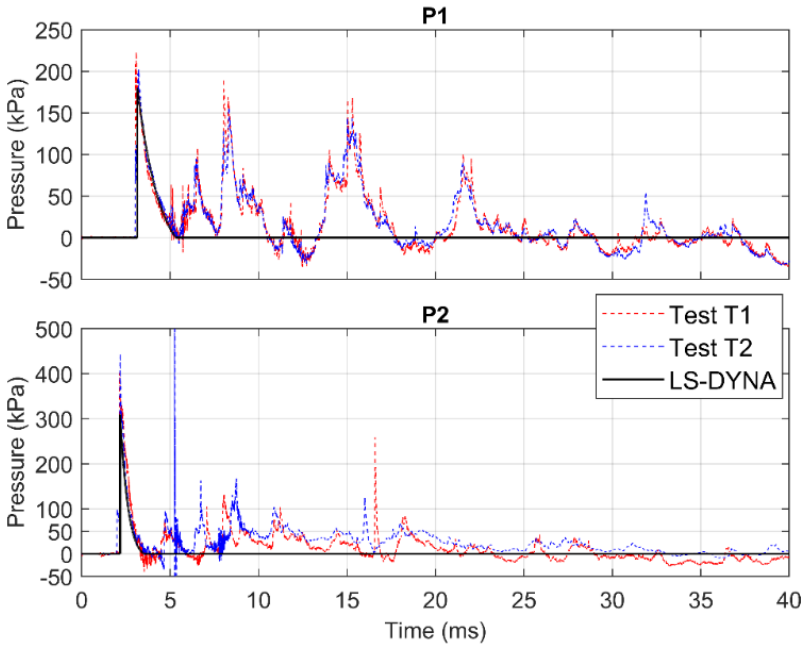
Figure 9. Pressure signals (P1 and P2) for tests T1 and T2: black powder, and the simulated signal with LS ‐ DYNA.